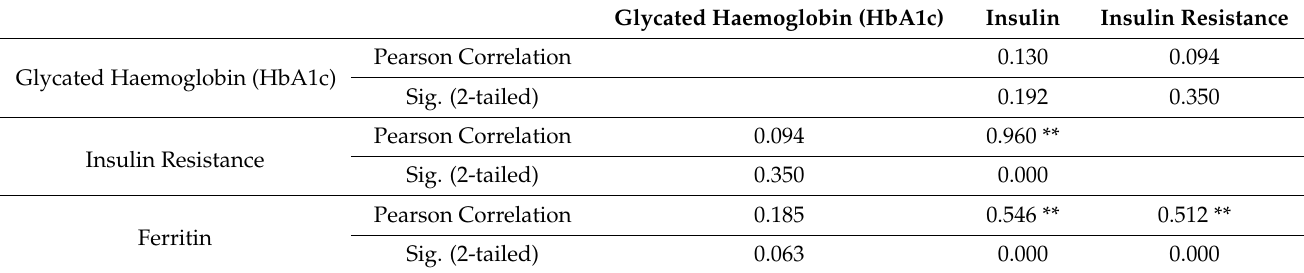
Table 2. Showing Pearson correlation of serum ferritin with HbA1c, insulin and insulin resistance.